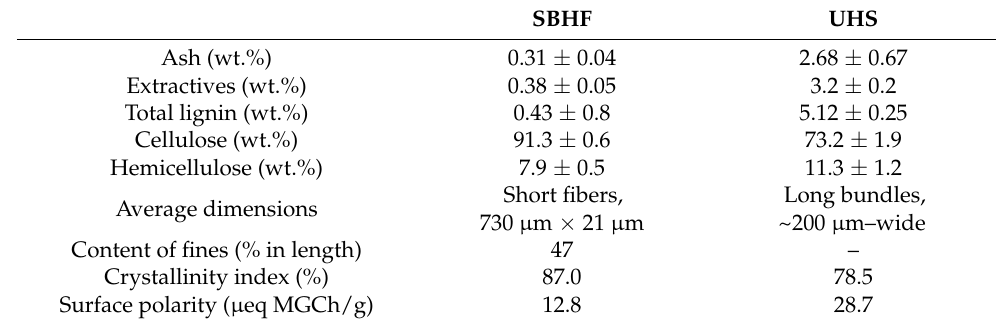
Table 1. Basic chemical composition and key properties of SBHFs, in comparison to the untreated strands. SBHF UHS Ash (wt.%) 0.31 ± 0.04 2.68 ± 0.67 Extractives (wt.%) 0.38 ± 0.05 3.2 ± 0.2 Total lignin (wt.%) 0.43 ± 0.8 5.12 ± 0.25 Cellulose (wt.%) 91.3 ± 0.6 73.2 ± 1.9 Hemicellulose (wt.%) 7.9 ± 0.5 Short fibers, Average dimensions 730 µ m × 21 µ m Content of fines (% in length) Crystallinity index